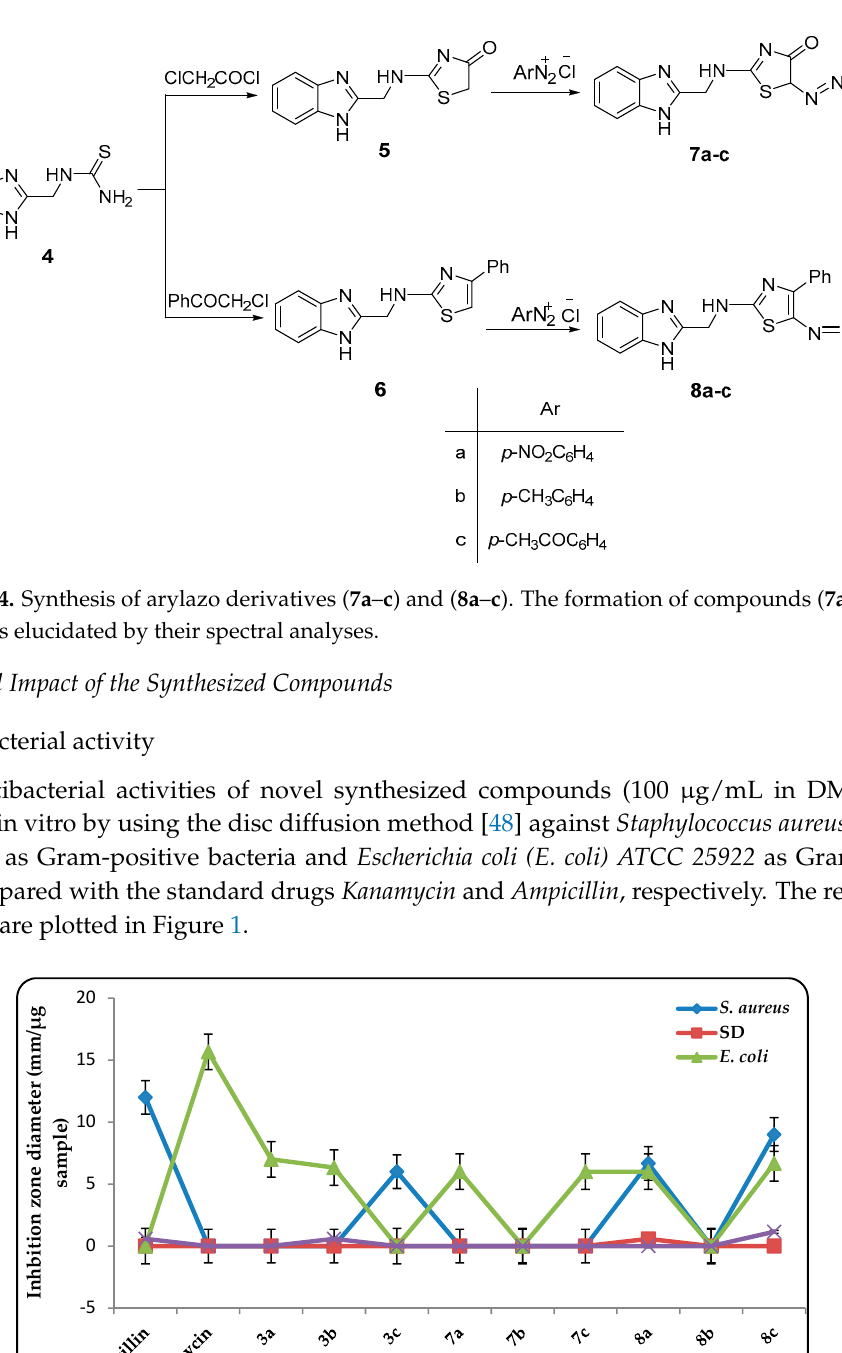
Figure 1 Antimicrobial activity of the tested benzimidazole derivatives vis-à-vis selected pathogenic bacteria strains comparing with standard drugs.